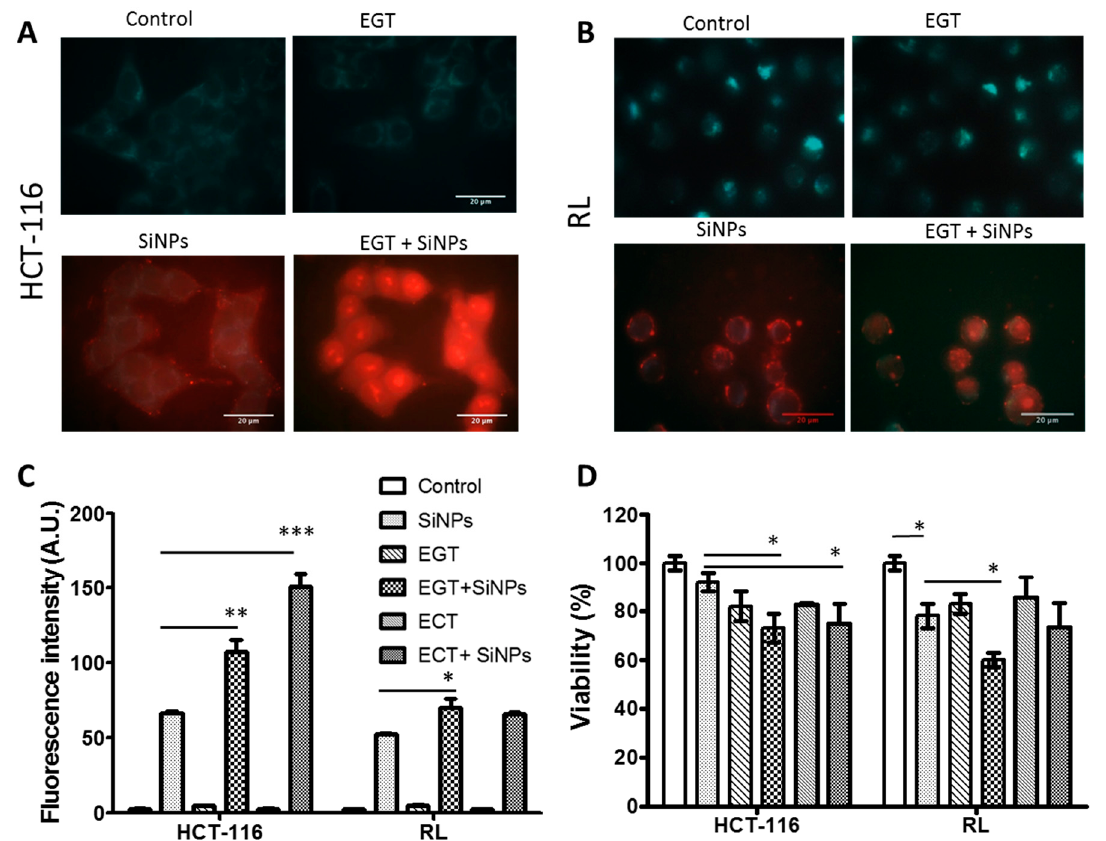
Figure 6. LumiLys 650 NPs uptake in cells and viability upon electropermeabilization. ( A , B ) Visualization of the electrotransfer of LumiLys 650 NPs after EGT (10 pulses 5 ms, 700 V/cm, 1 Hz) in ( A ) HCT-116 and ( B ) RL cells. ( C ) Histogram representing the average fluorescence intensity of HCT-116 and RL cells 24 h after treatment. For HCT-116 cells, EGT (10 pulses 5 ms, 700 V/cm, 1 Hz) and ECT (8 pulses 100 µ s, 800 V/cm) parameters were applied in the presence of 100 µ g/mL SiNPs. For RL cells, EGT (10 pulses 5 ms, 700 V/cm, 1 Hz) and ECT (8 pulses 100 µ s, 1500 V/cm) parameters were applied in the presence of 75 µ g/mL LumiLys 650 NPs. ( D ) Histogram representing the average HCT-116 and RL cell viability 24 h after treatment for the corresponding experimental conditions. Histograms represent the mean +/ − S.D. of three independent experiments. Data were considered statistically significant from a p-threshold of less than 0.05 (* p < 0.05; ** p < 0.01; *** p <